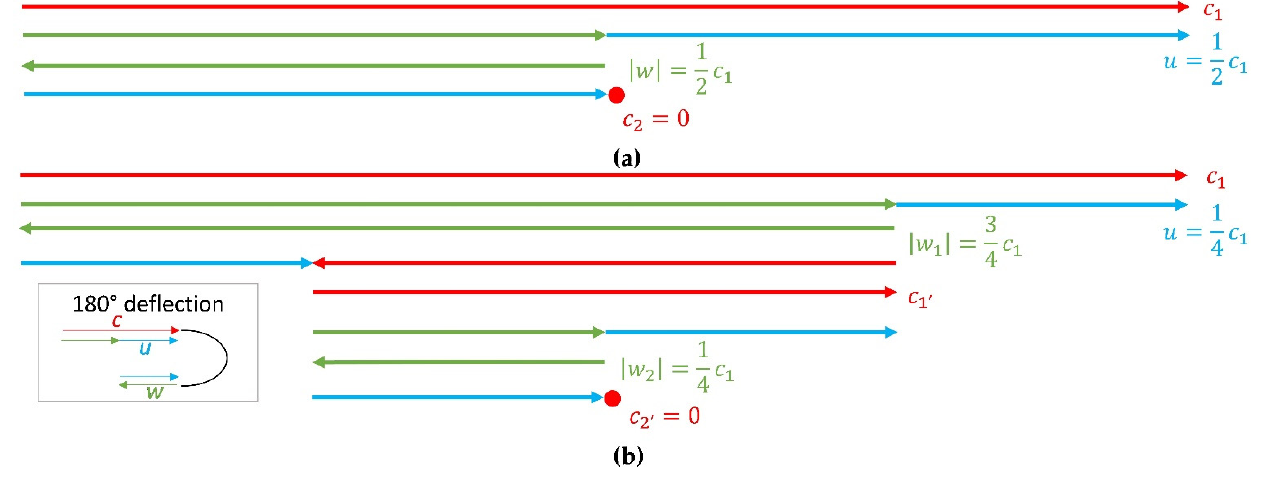
Figure 1. Comparison of velocity triangles: ( a ) ideal 180° deflecting impulse turbine; ( b ) ideal veloc- ity compounded turbine with two velocity stages.